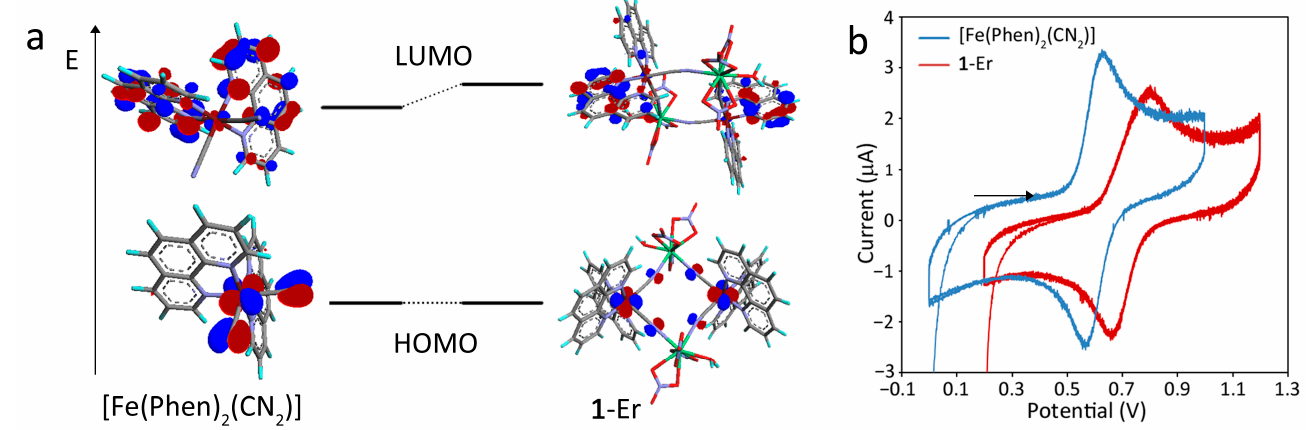
Figure 6. ( a ) DFT-calculated frontier molecular orbitals for [Fe(Phen) 2 (CN) 2 ] (left) and 1 -Ln (right). ( b ) Cyclic voltammograms of [Fe(Phen) 2 (CN) 2 ] and 1 -Ln in CH 3 CN solution against Ag/AgCl electrode. The arrow indicates the scan direction.